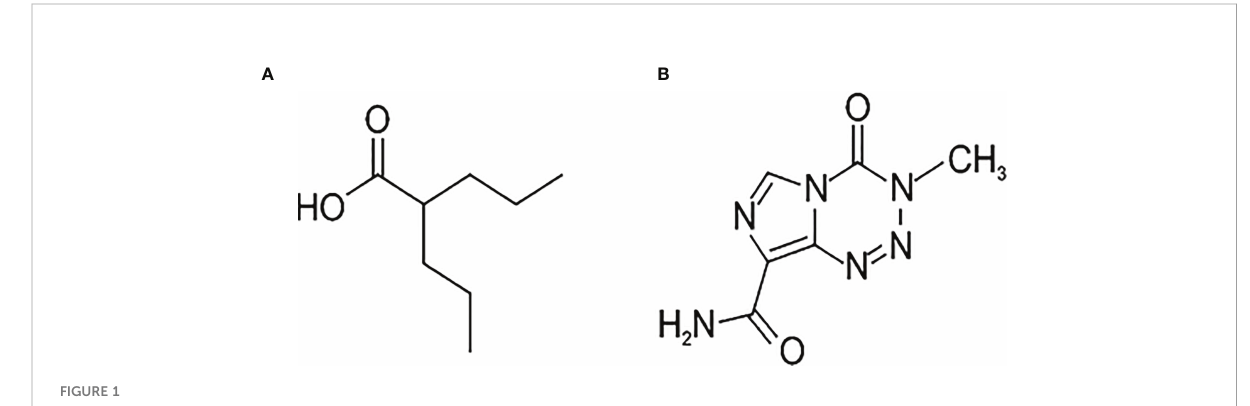
FIGURE 1 Chemical formulae of Valproic acid – (A) and temozolamide – (B)